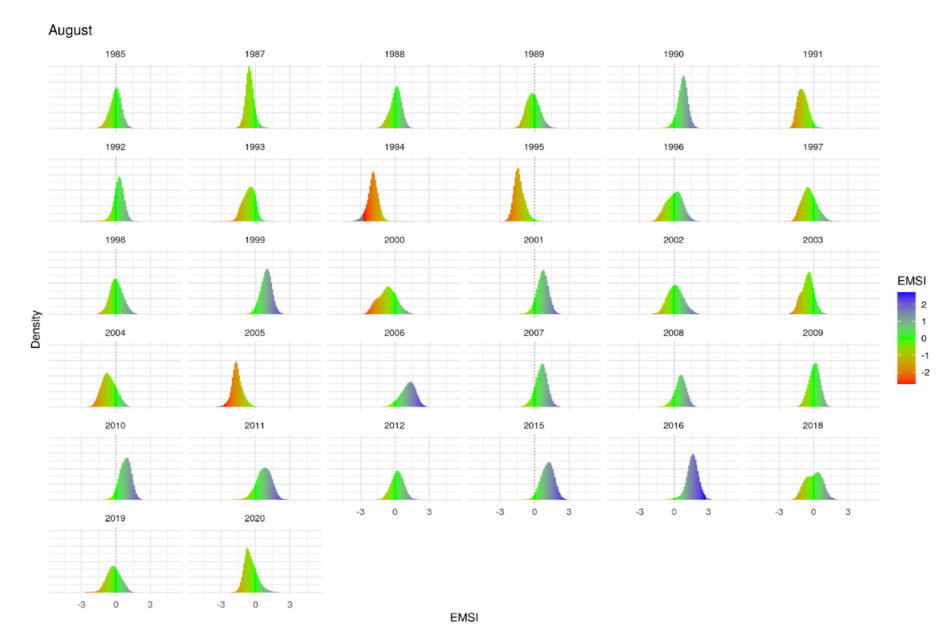
Figure 9. Histograms of the raster pixel distributions for EMSI across the entire time series for US Mexico border region with the reference period set over all 36 years (four years are absent due to lack of clear sky scenes). Years with deeper departures from normal are exemplified by redder or bluer